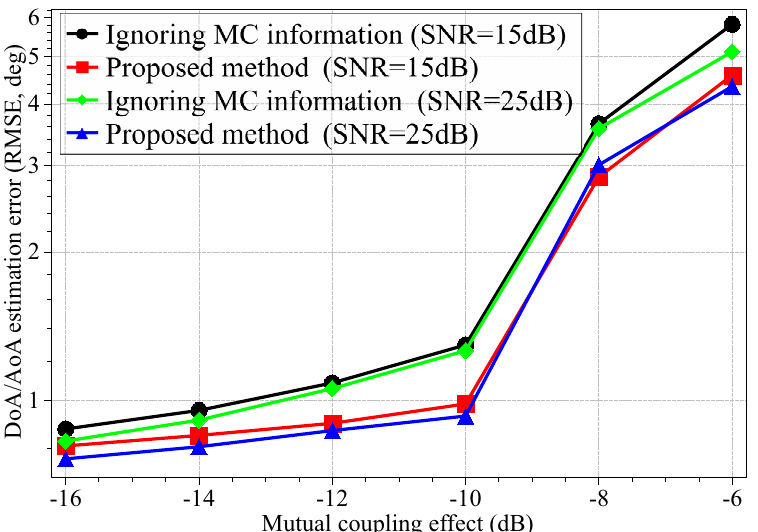
Figure 4. The DoD/DoA estimation performance with different MC